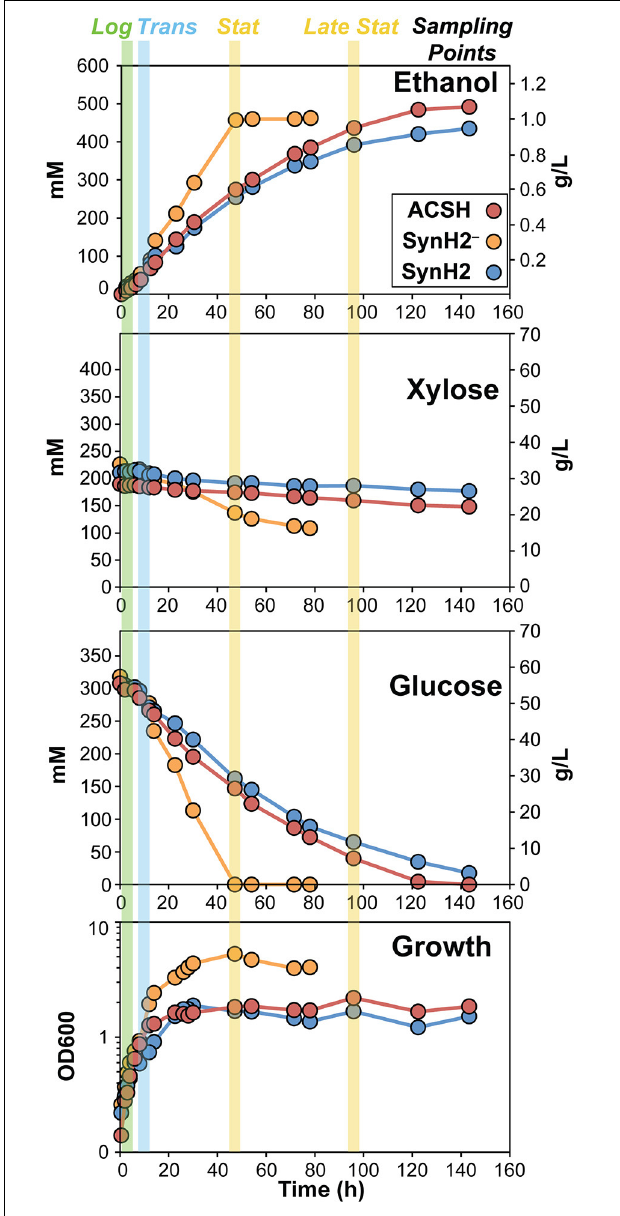
FIGURE 1 | Growth, sugar utilization, and ethanol production of GLBRCE1 in ACSH, SynH2, and SynH2 − . GLBRCE1 was cultured under anaerobic conditions at 37 ◦ C in a bioreactor in ACSH, SynH2, or SynH2 − (SynH2 lacking aromatic inhibitors; Materials and Methods). Cell density measurements ( bottom panel ), changes in glucose and xylose concentrations in the extracellular medium ( middle panels ), and ethanol concentrations in the vessel ( top panel ) were periodically determined and plotted relative to time. Blue, green, and yellow shaded bars represent points at which samples for metabolite, RNA, and protein analyses were collected during exponential, transition, and stationary phases of growth.